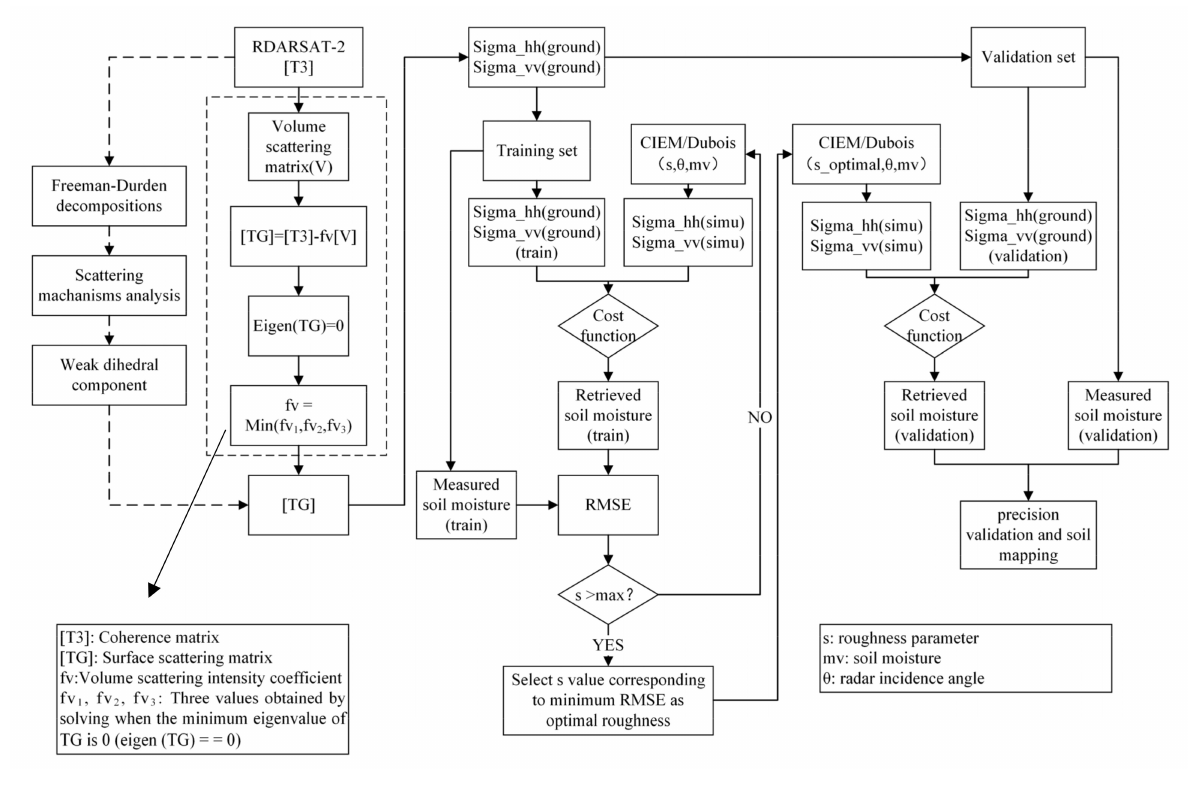
Figure 2. Workflow of soil moisture retrieval.